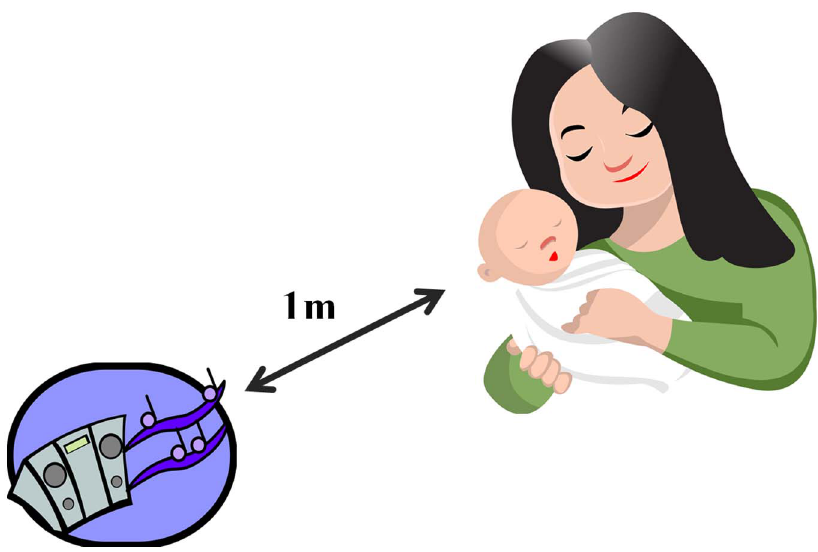
Figure 2. Mothers and infants listened to two music fragments. One group of the mothers maintained close body contact with their infants. The other mothers were asked to take a seated position next to the infant without close body contact. The music stereo installation was placed 1 meter from the participants. The music stimulus was played at 60 db.